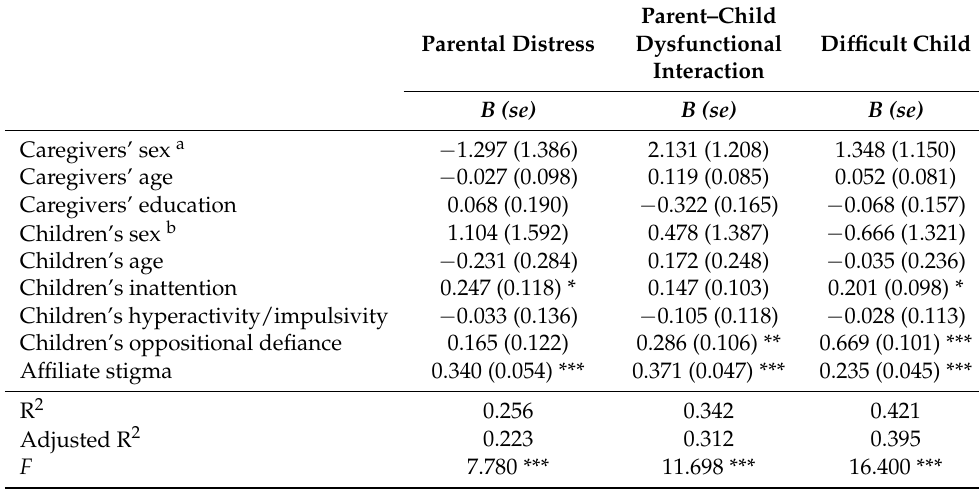
Table 2. Associations of Child and Caregiver Factors and Affiliate Stigma with Parenting Stress: Multivariate Linear Regression.